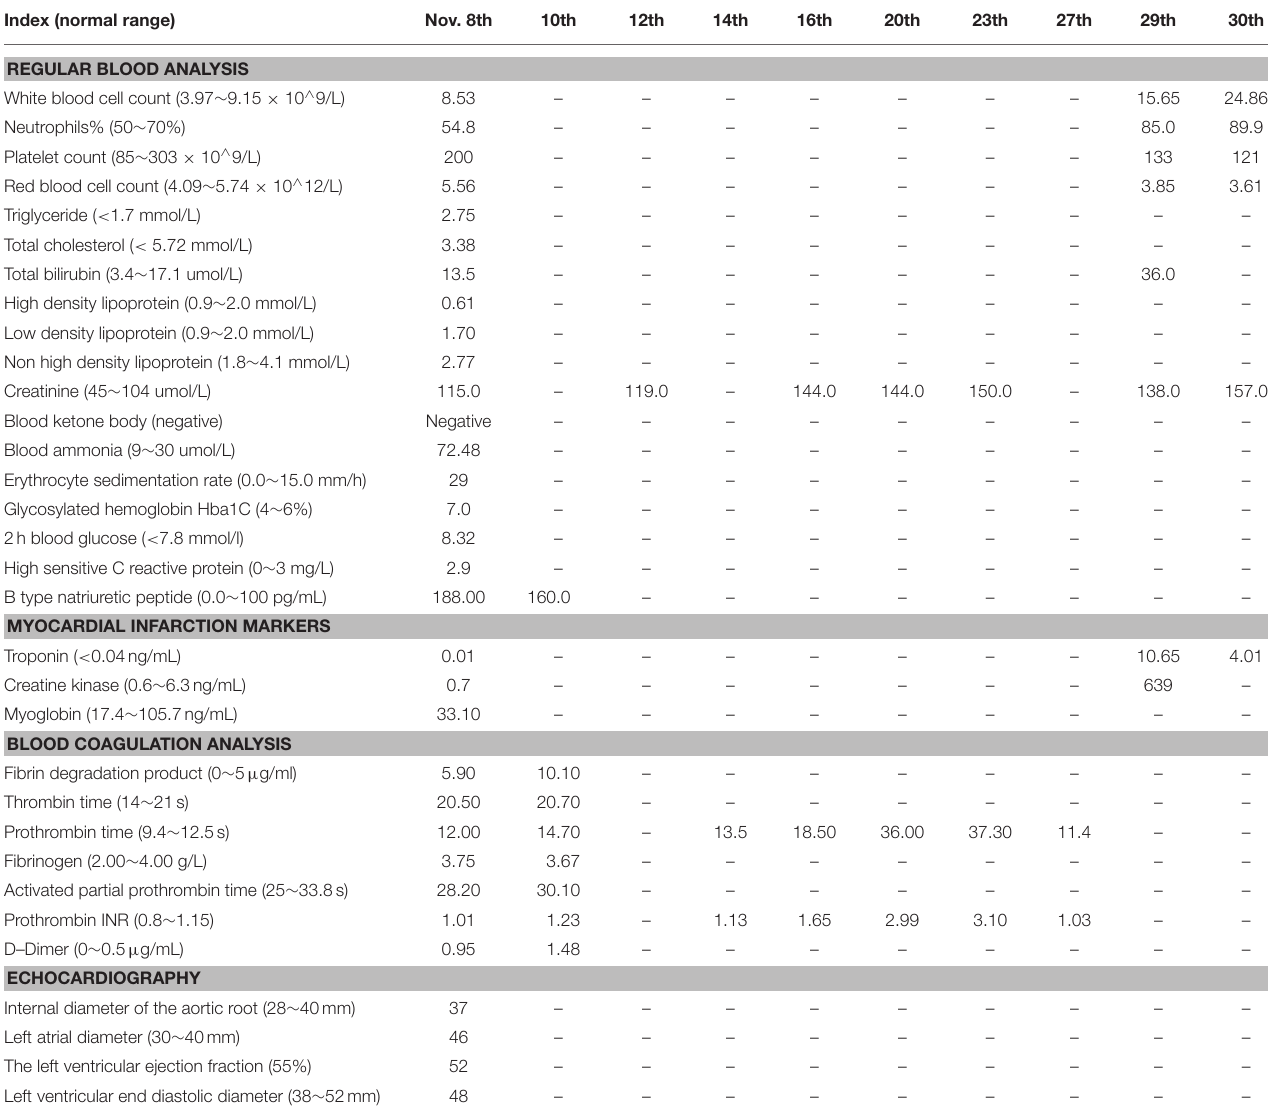
TABLE 2 | Results of main laboratory